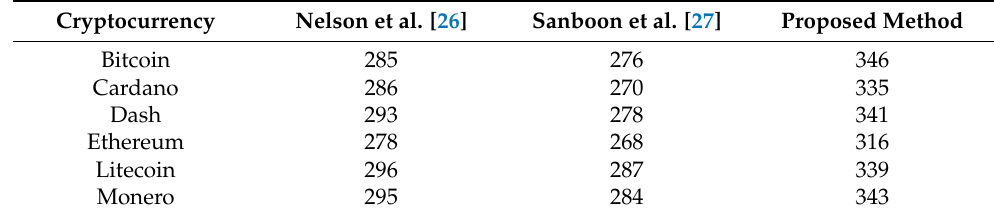
Table 10. The number of times each method correctly predicted out of a total of 402 test